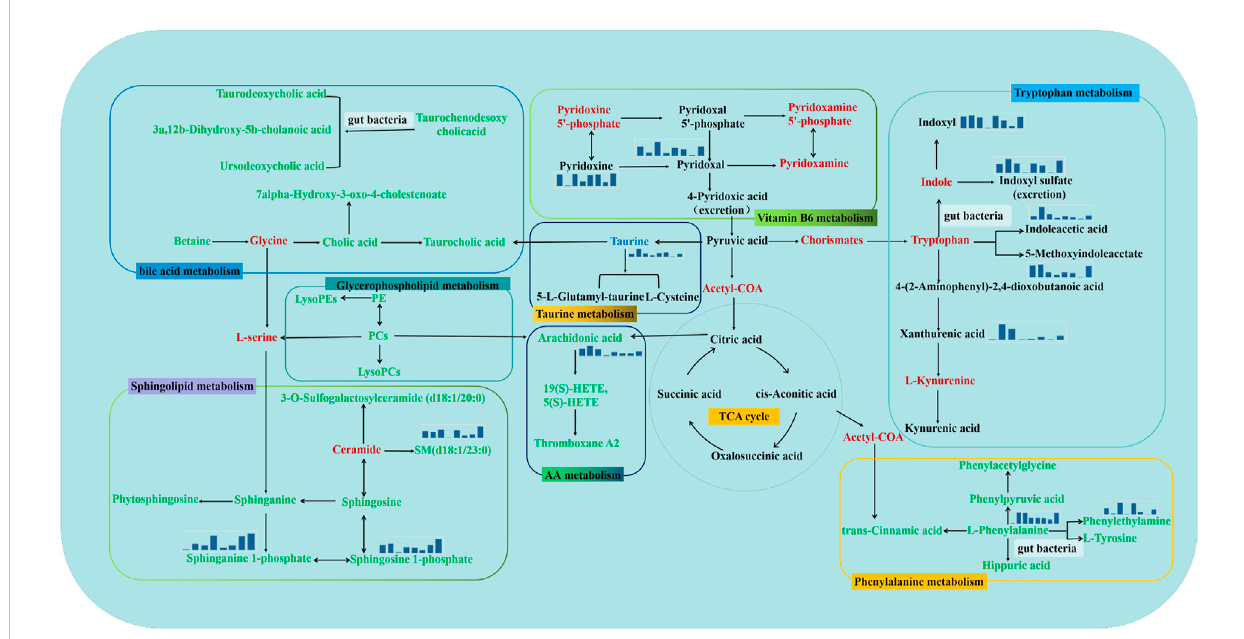
FIGURE 5 Metabolic pathway analysis, re fl ecting the inner relationship among potential biomarkers intervened by DS, DS-Pol, DS-Oli, DS-FG, DS-FA, DS-FO treatment. It was marked red as absent metabolites, metabolites labeled in black were from urine, labeled in green were from serum. Mini bar chart represents average content of main biomarkers in NC, PE, DS, DS-Pol, DS-Oli, DS-FG, DS-FA, DS-FO